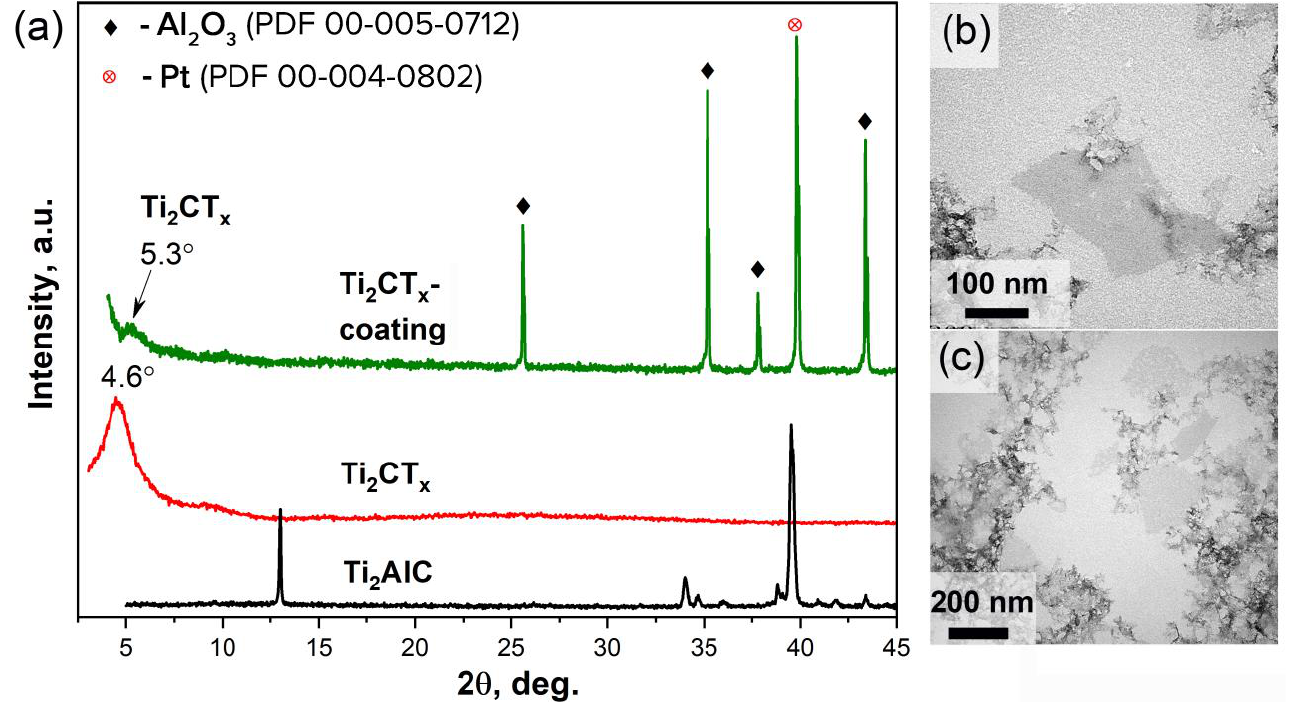
Figure 1. The X-ray patterns of the initial Ti 2 AlC, low-layer Ti 2 CT x MXene and its coating on a specialized sensor substrate ( a ), and TEM microphotographs of Ti 2 CT x MXene ( b , c ).